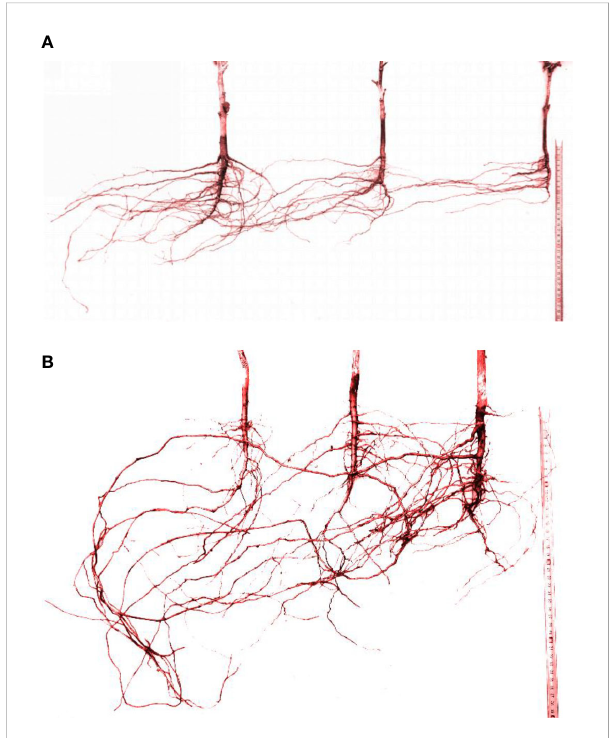
FIGURE 5 Root system architecture of the cotton group in Boll stage. (A) 30- cm planting spacing. (B) 15-cm planting